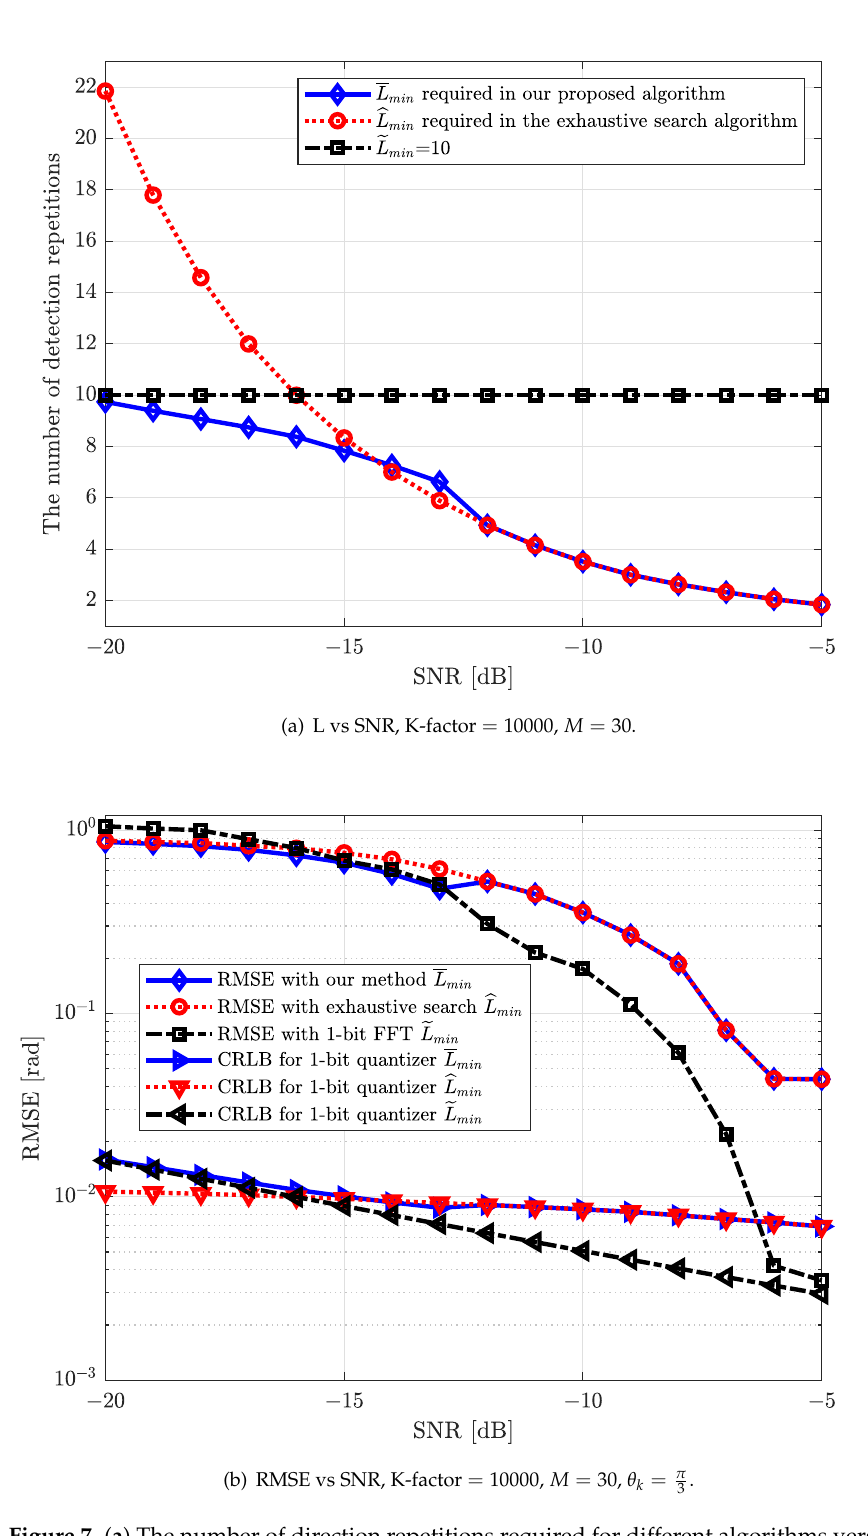
Figure 7. ( a ) The number of direction repetitions required for different algorithms versus different SNRs for M = 30; ( b ) RMSE [rad] versus different SNRs for M = 30 with our proposed beamforming direction search algorithm, the exhaustive search algorithm and 1-bit